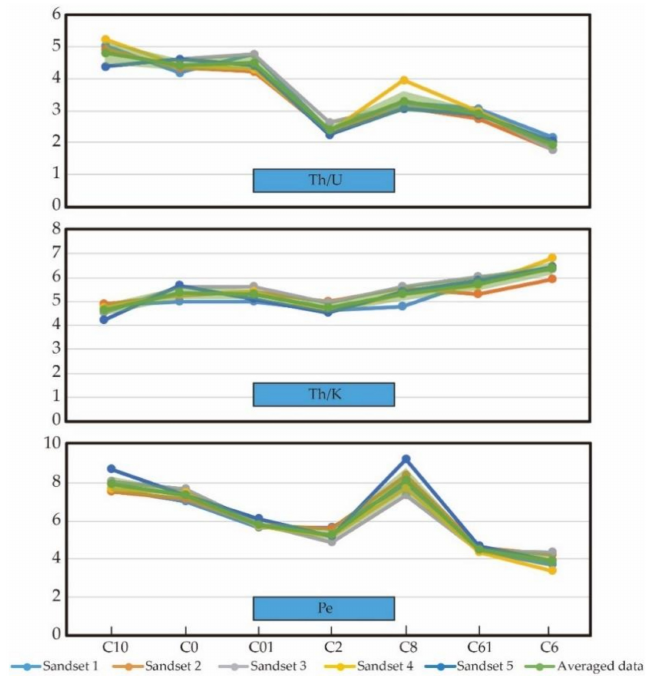
Figure 4. The variations of Th/U, Th/K, and Pe in each well, corresponding to Table 1. Green shades are intervals of ± standard deviation